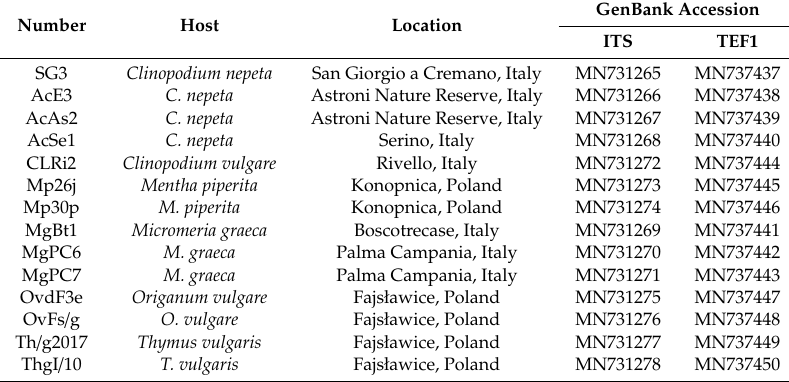
Table 2. Isolates of B. dothidea from Asphondylia galls collected on Lamiaceae used in this